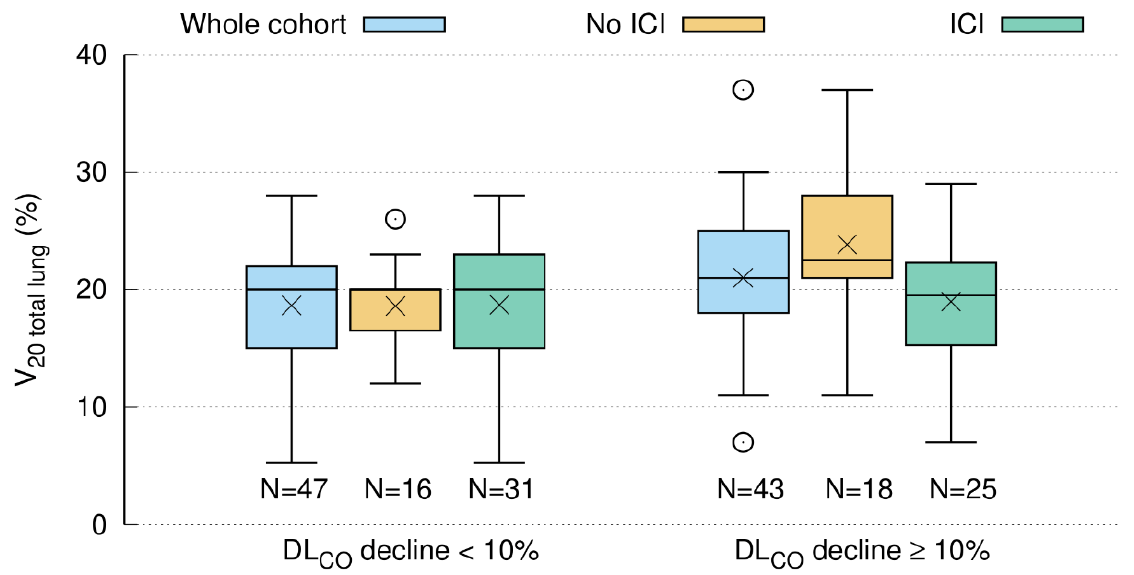
Figure A3. In the non-immunotherapy subgroup (brown), patients with a DL CO decline of 10% or more after the end of RT had a significantly higher V 20 total lung . The Bonferroni correction was applied to adjust for multiple testing: n = 34, Pearson correlation coefficient = 0.466 (corrected p -value 0.039). In the whole cohort (blue) and the immunotherapy subgroup (green), this difference was not significant after correction for multiple testing. Median and mean are represented by horizontal lines and crosses, respectively.